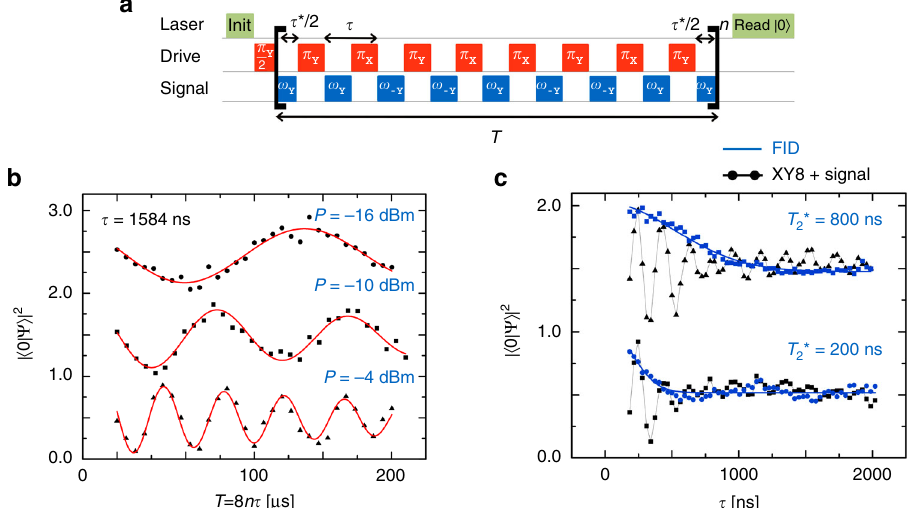
Fig. 4 Performance and limits of the method. a XY8 sequence employed to record the data of b , c . The signal was phase-cycled in order to maximize = 1.8 μ s, where the number of π pulses was increased up to 120 while keeping the pulse spacing τ and sensitivity. b Rabi oscillations much slower than T (cid:1) 2 the signal power P constant. c Signal decay for increasing pulse spacing. For a spacing τ > T (cid:1) , the pulsed Mollow protocol loses sensitivity. Data traces in b , c 2 have been shifted vertically by an offset of 1.0 for better comparison